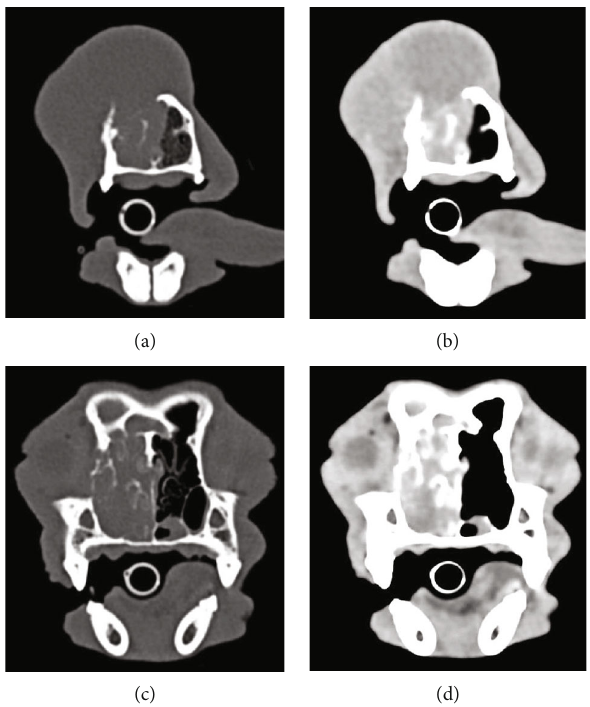
Figure 9: The soft tissue (b, d) and bone window (a, c) CT images obtained approximately 6 months after the images presented in Figure 6 approximate the levels shown in Figure 6. Despite palliative debulking procedures and 6 months of chemotherapy, no appreciable changes were noted in the deep-seated portions of the